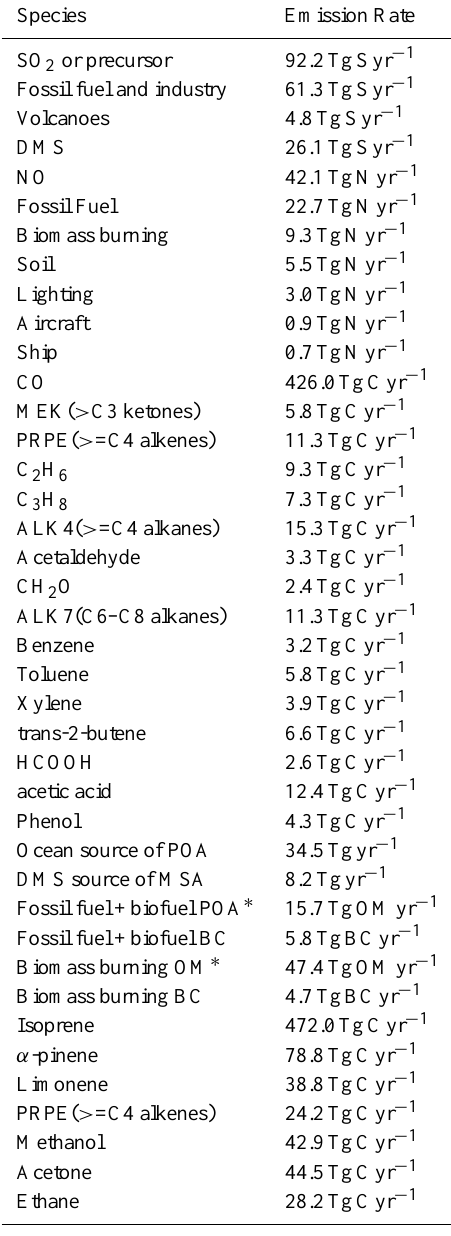
Table 2. Global emissions of gases, aerosols and aerosol